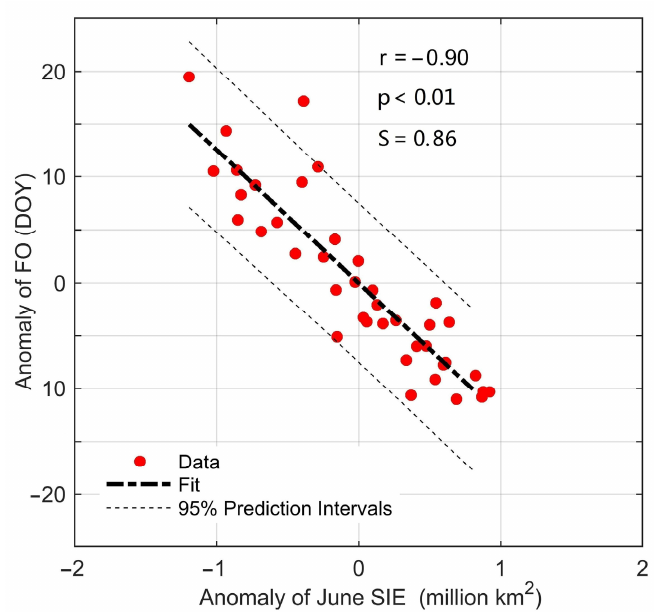
Figure 4. Scatterplot shows the relationship between the Arctic sea ice FO and June